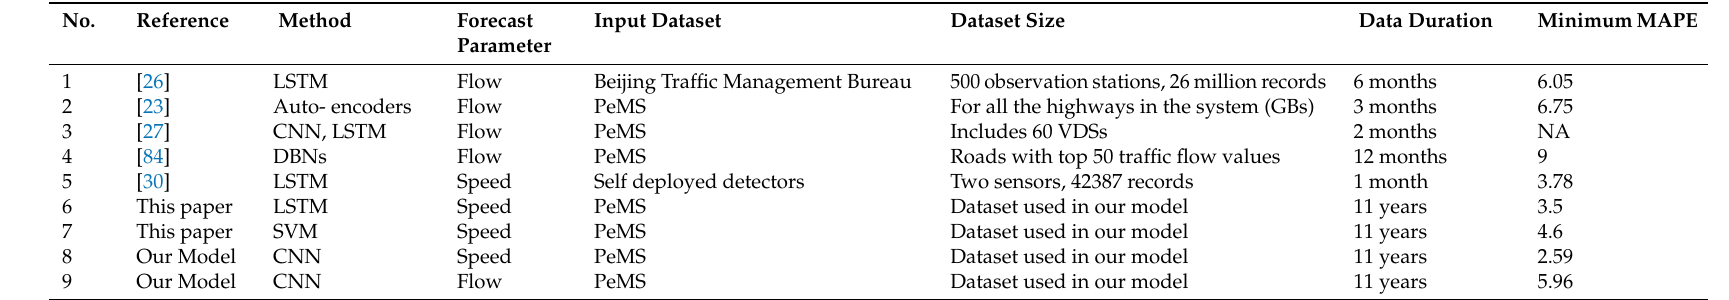
Table 6. Comparison of traffic prediction